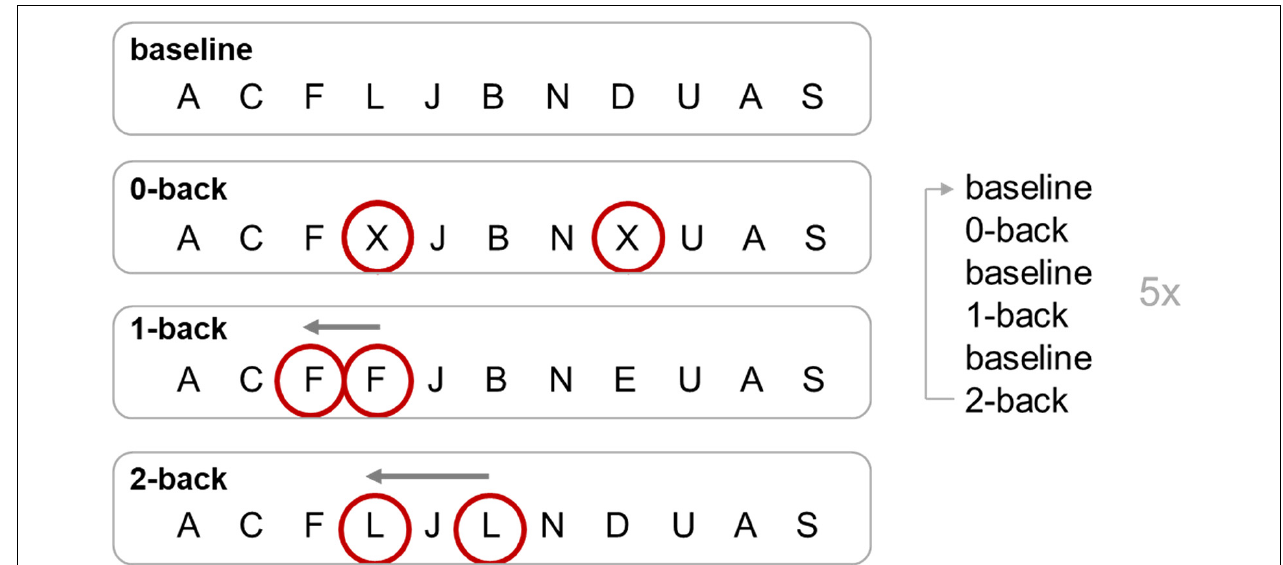
FIGURE 1 | n-back task. Targets of each condition of the n-back task are circled. The 0-back, 1-back, and 2-back conditions were repeated five times, alternating with the baseline condition. For 0-back, a response on a certain target letter is required (button press for X); for 1-back, the response is required for a repetition of a target letter (e.g., second F); for 2-back, the response has to be on the last but one repetition of the target letter (e.g., L, J, L; response to the